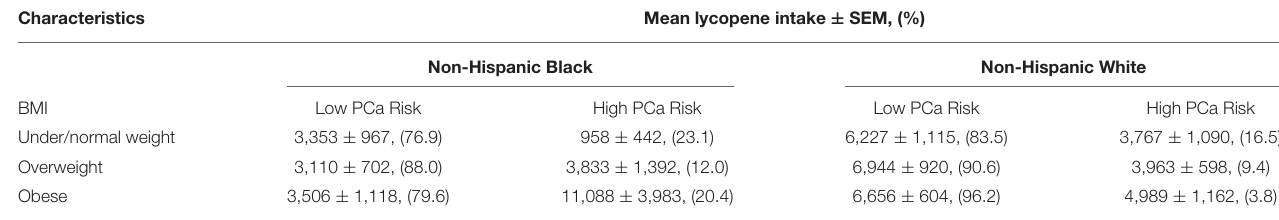
TABLE 5 | Comparison of lycopene intake (mcg) between PCa risk groups under different BMI conditions.